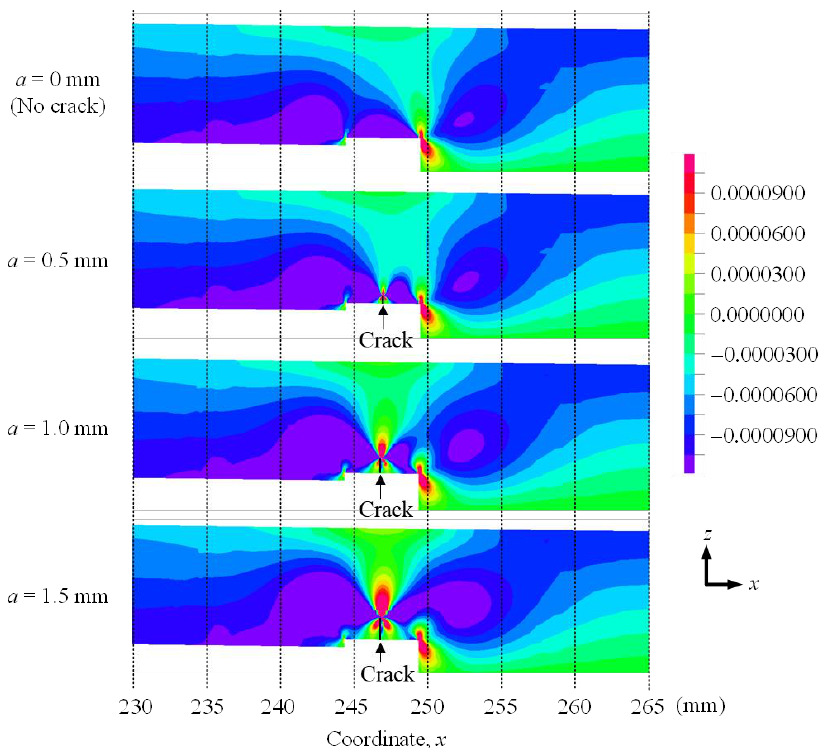
Figure 7. The strain distribution ( ε z ) of Model 2D, a = 0, 0.5, 1.0, 1.5 mm.